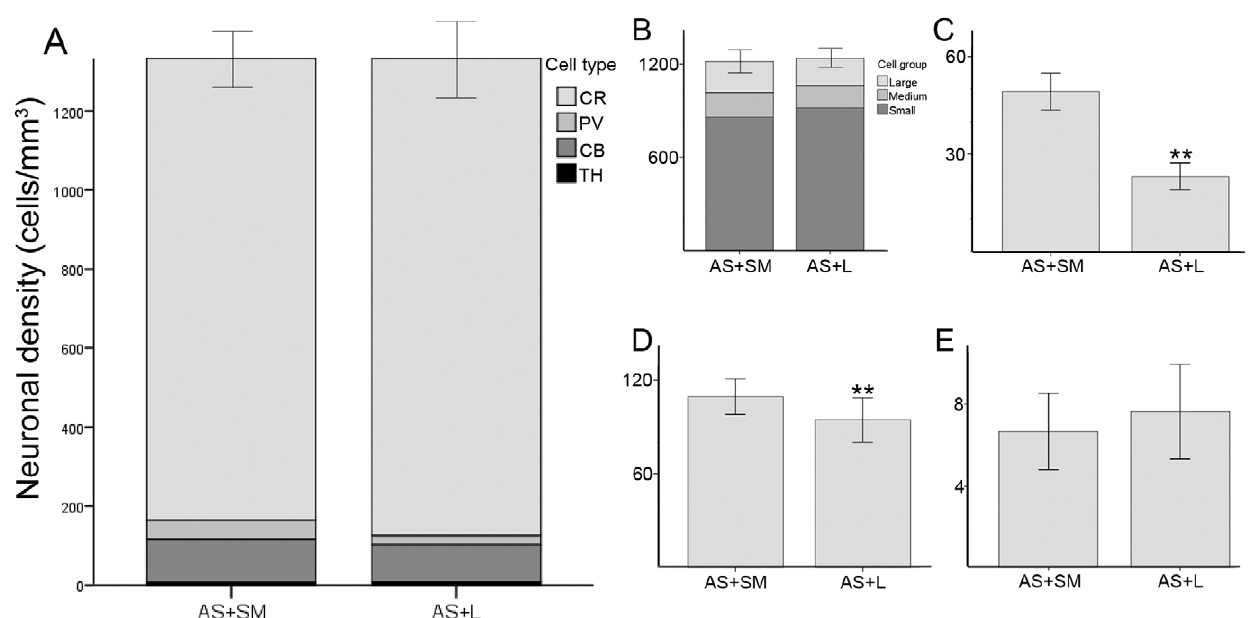
Figure 4. Mean neuronal density in the striatal territories with overlapped projections. A, stack bar graph showing the global interneuronal density (cells/mm 3 ). The stacks indicate different groups of neurons. B, stack bar showing the density of CR-ir interneurons (cells/mm 3 ) and their morphological subgroups. C–E, neuronal density of the PV-, CB- and TH-ir neurons, respectively (cells/mm 3 ). Error bars indicate the SEM. **, P , 0.01. AS + L, associative + limbic; AS + SM, associative + sensorimotor.